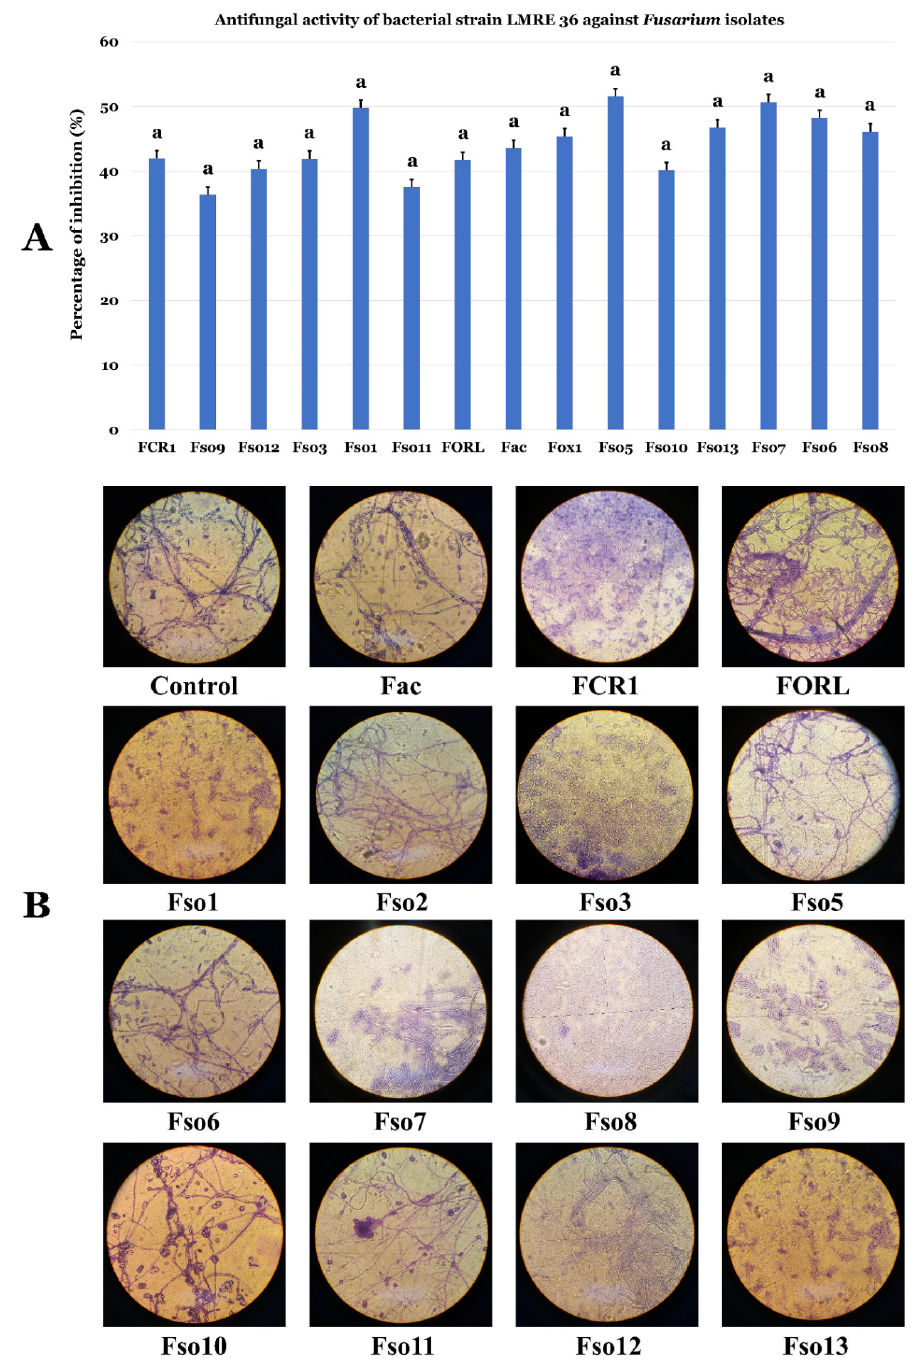
Figure 10. ( A ) Antifungal activity of bacterial strain LMRE 36 against Fusarium isolates. Data presents mean ± standard error. Bars labelled with the same letters were not significantly di ff erent among the treatments at p < 0.05 using Tukey’s HSD test. ( B ) Microscopical confrontation assay of LMRE36 against di ff erent Fusarium